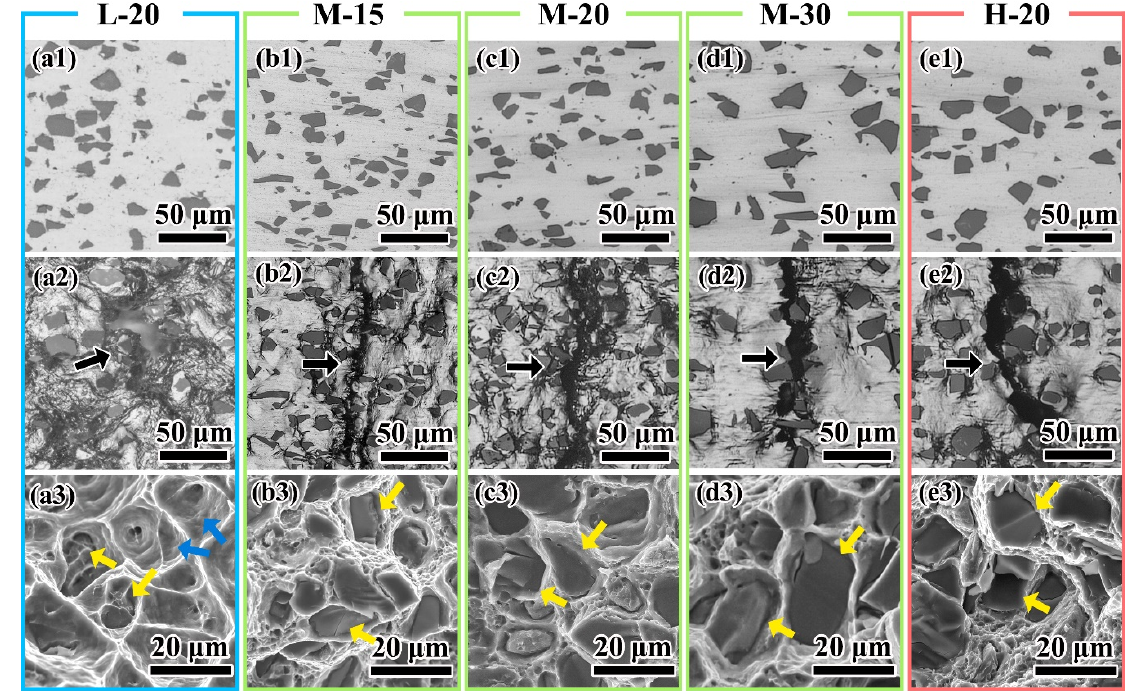
Figure 6. Crack propagation and fracture morphology of ( a ) L-20, ( b ) M-15, ( c ) M-20, ( d ) M-30, and ( e ) H-20. The state of mages in every groups are (1) before loading, (2) after fracture in the region in which the main crack (pointed by arrow) passes through, and (3) the fracture morphology of the main crack.